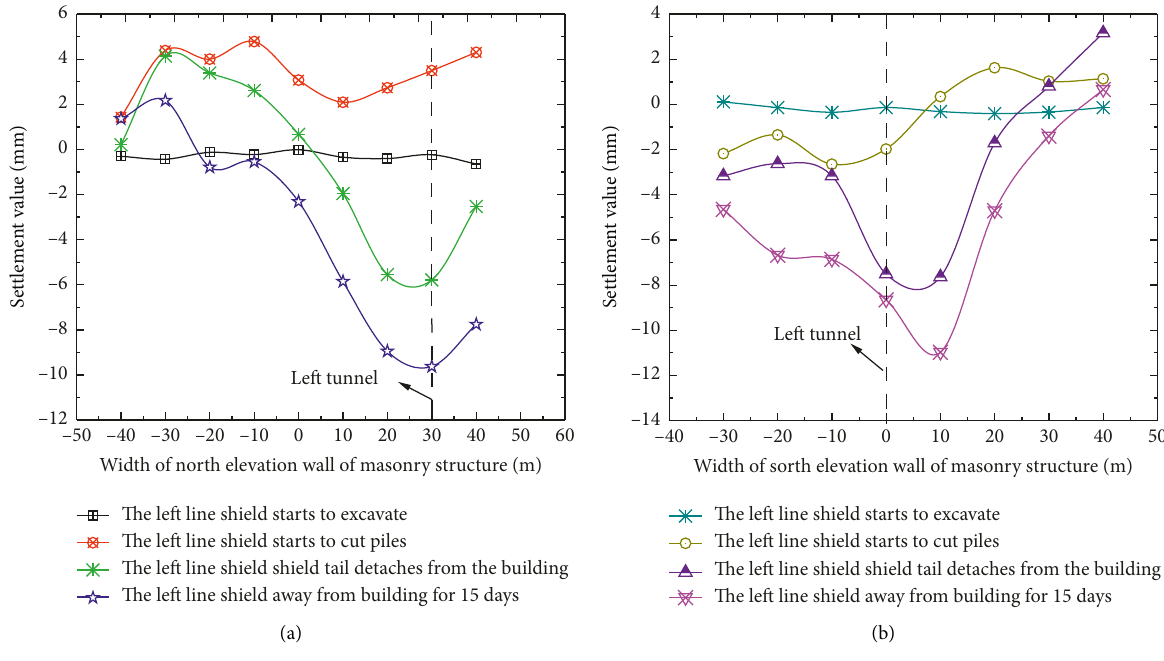
The left line shield starts to excavate The left line shield starts to cut piles The left line shield shield tail detaches from the building The left line shield away from building for 15 days Figure 13: The settlement curve: (a) north facade and (b) south facade wall of the building at the critical